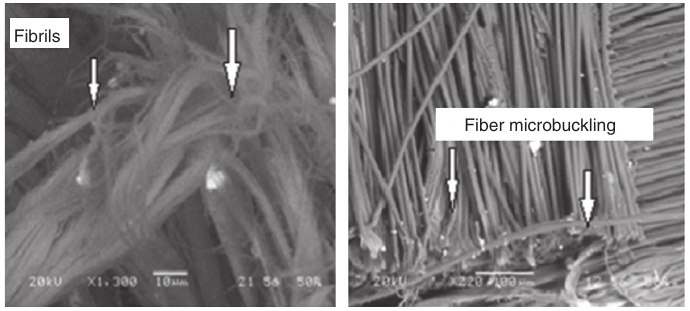
samples shows the fibrils and fiber Figure 7 SEM micrographs of LN 2 further evidence of the microbuckling failure mechanisms as shown in Figure 7. The fractographic features shown on the fiber ends exhibit a morphology particular to the laminate compression failure. Across each individual fiber end is a line, which represents the neutral axis of the fiber as it undergoes bending. A microbuckling may occur on several planes, giving rise to a series of steps on the frac- ture surface, each step being a multiple of half the buck- ling wavelength. During failure involving compressive stresses, fibrillation occurs, which results in a large degree of new surface area. This fibrillation process results in a high-energy absorption during the process of failure.